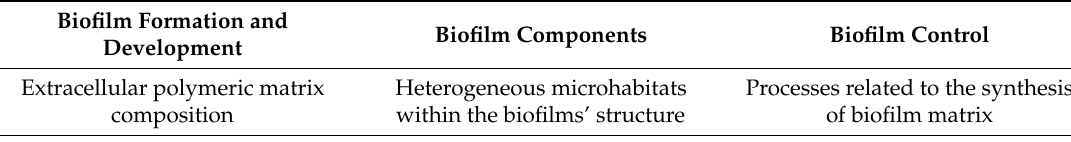
Table 1. Main features regarding key points for future studies on marine